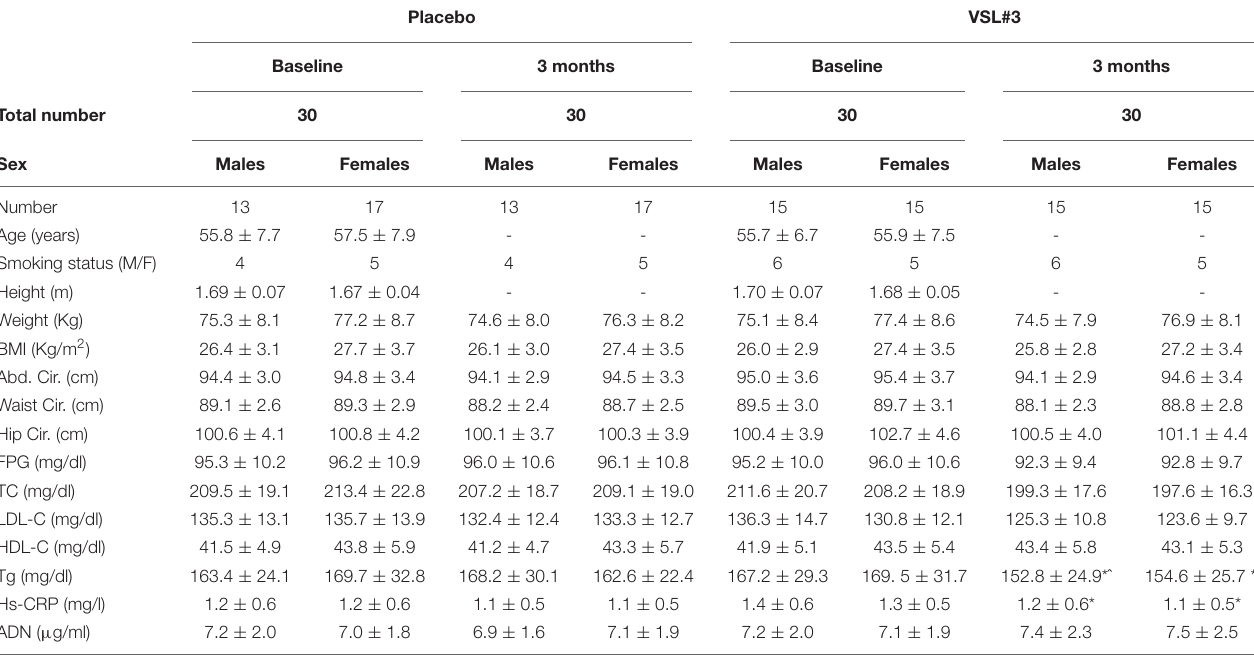
TABLE 1 | VSL#3 R (cid:13) treatment at baseline and after 3